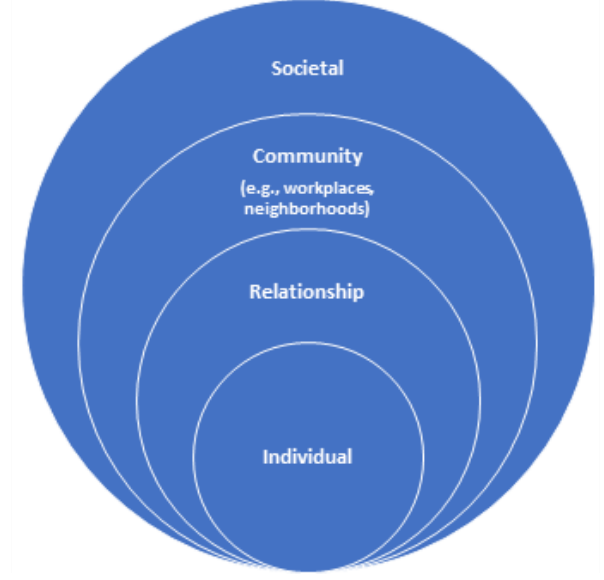
Figure 2. Socioecological Model for Prevention.